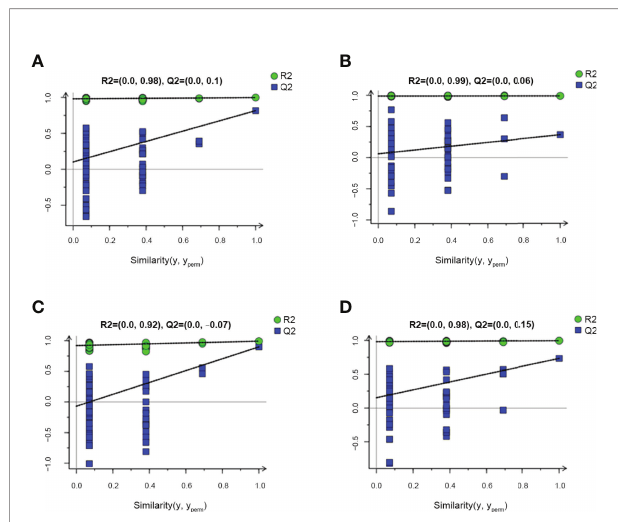
FIGURE 4 | Permutation plots for pairwise comparisons between UV-WSSV trained immunity and control groups. (A) EU vs. CP, (B) EW vs. CW, (C) CW vs. CP, and (D) EW vs. EU groups.